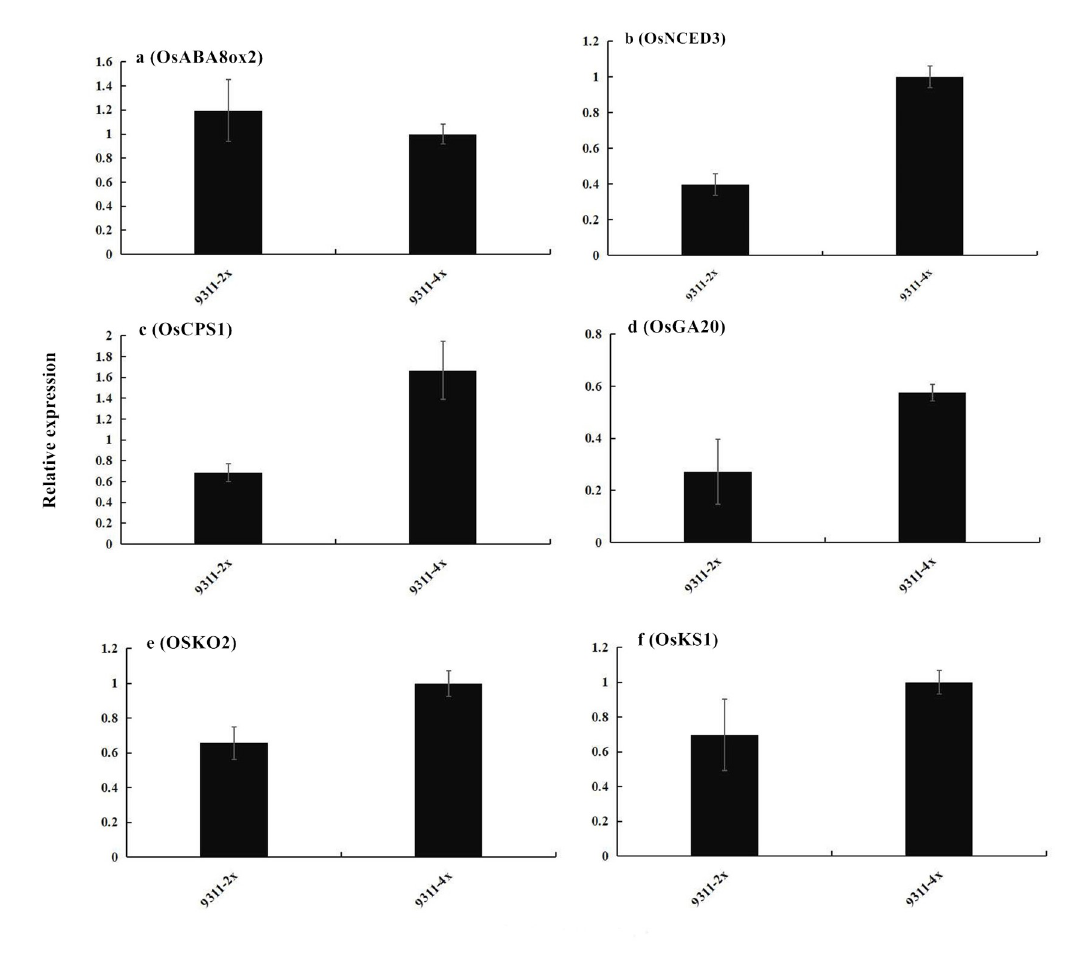
Fig 8. The relative expression of genes associated with the regulation of abscisic acid (ABA) synthesis/decomposition and gibberellin (GA) synthesis in 9311-2x and 9311-4x rice. (a) OsABA8ox2 , gene regulating ABA degradation; (b) OsNCED3 , gene for ABA synthesis; (c) OsCPS1 , gene for GA synthesis; (d) OsGA20 , gene for GA synthesis; (e) OsKO2 , gene for GA synthesis; (f) OsKS1 , gene for GA synthesis. Values are the means ±